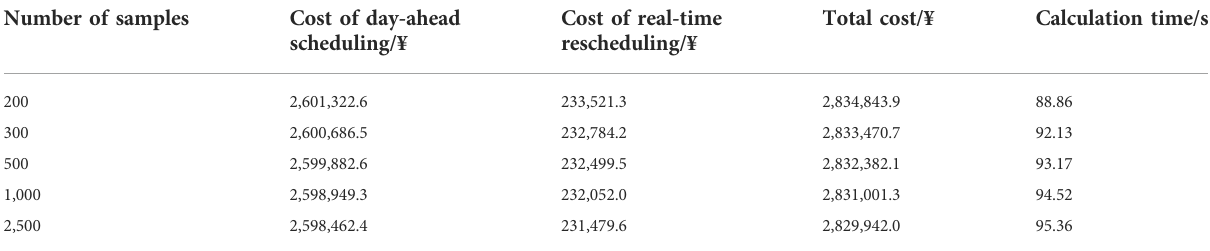
TABLE 7 Results comparison of different samples.